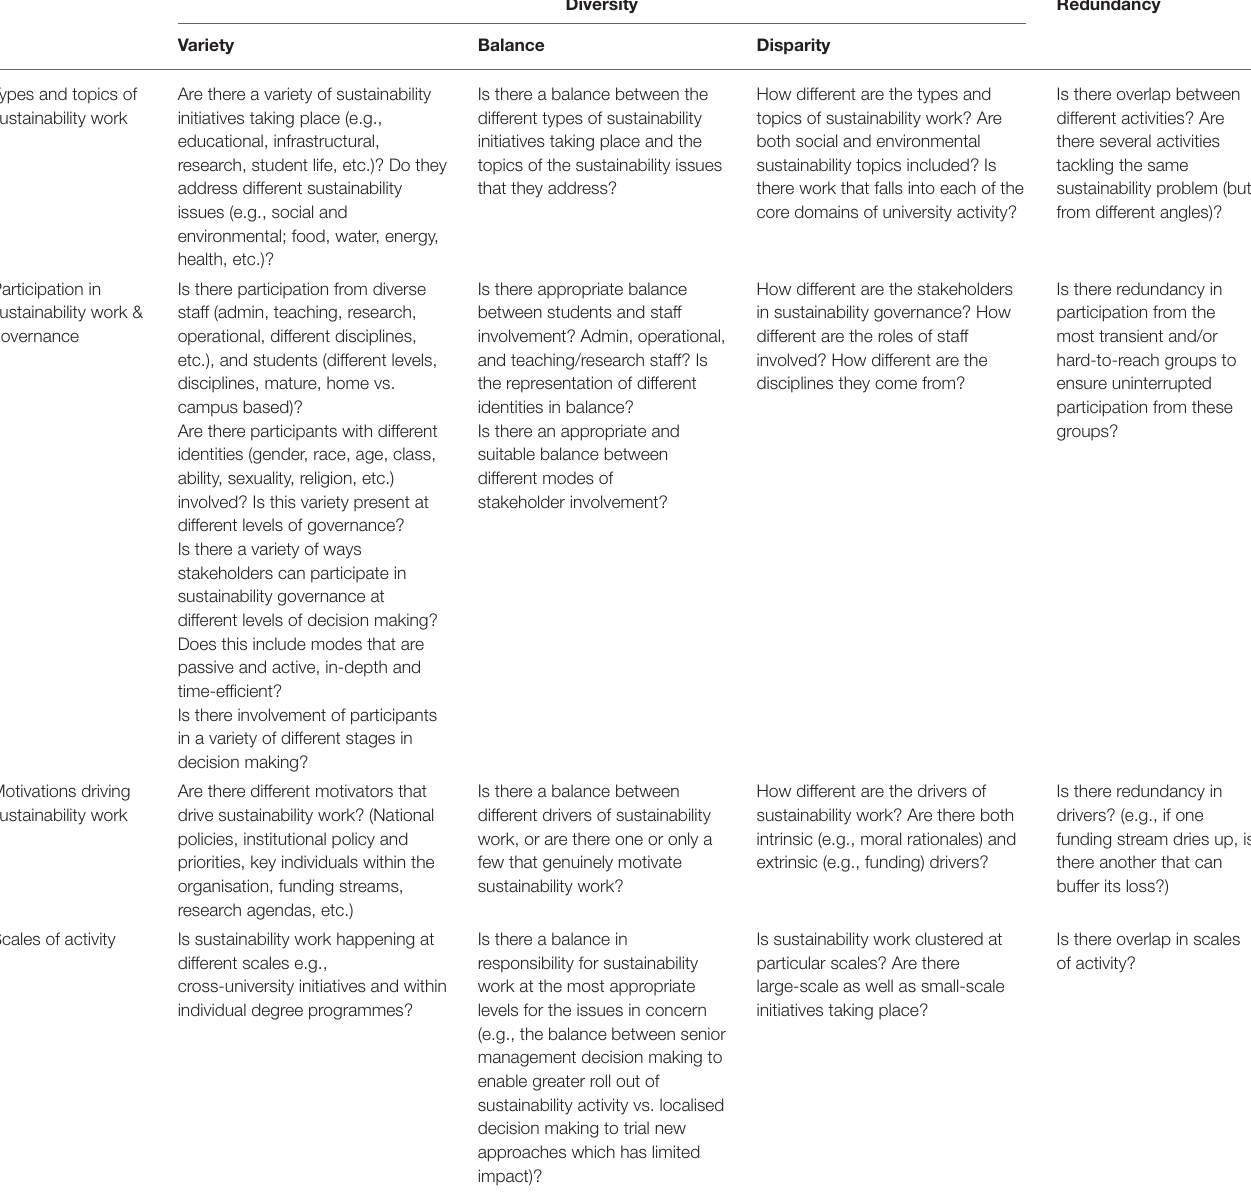
TABLE 1 | Examples of elements of university governance for sustainability in relation to Biggs et al.’s (2012, 2015) three types of diversity and redundancy. Diversity Redundancy Variety Balance